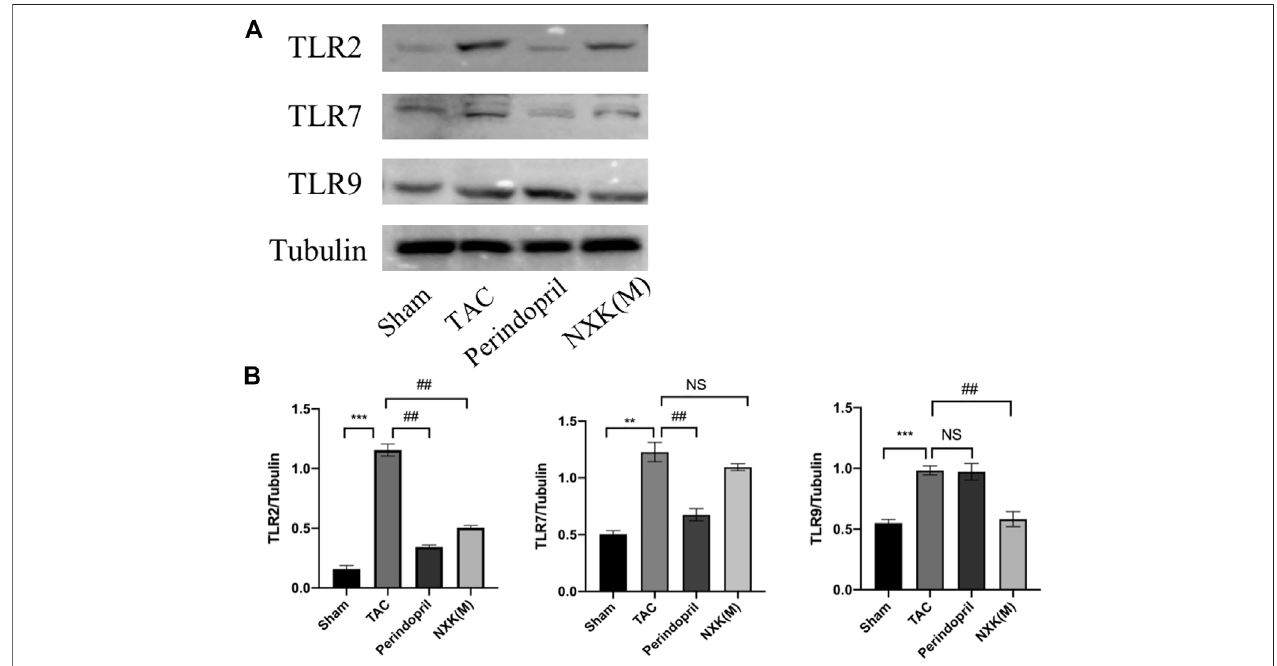
FIGURE 7 | Western blot analysis was used to measure the protein levels of TLR2, TLR7, and TLR9 pathway proteins. (A) Expression levels of TLR2, TLR7, and TLR9 proteins in different mice groups and quanti fi cation was performed after normalization to GAPDH ( n = 6 per group). (B) Values are shown as means ± SD, compared to the sham group * p < 0.05, ** p < 0.01, *** p < 0.001, compared to the Tac group # p < 0.05, ## p < 0.01, ### p < 0.001.